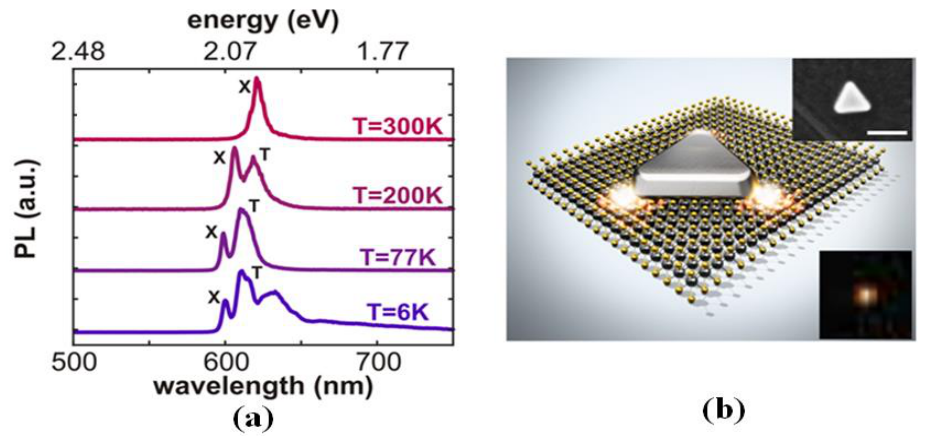
17 of 24 Figure 18. Typical MoSe 2 flake transferred to Au nanodisk arrays. ( a ) Schematic showing the MoSe 2 monolayer coated on top of the Au nanodisk array on a SiO 2 substrate. ( b ) Bright field optical microscopy image (50× magnification) of MoSe 2 monolayer transferred to Au nanodisk array and fabricated using the shaped nanosphere lithography process [99]. Cuadra et al. [100] reported on the strong interactions between localized surface plasmons in silver nanoprisms and the excitons and trions in monolayer tungsten disulfide (WS 2 ). Their